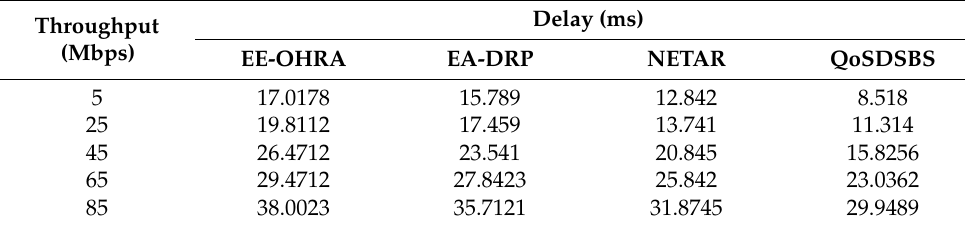
Table 6. Results of throughput vs.